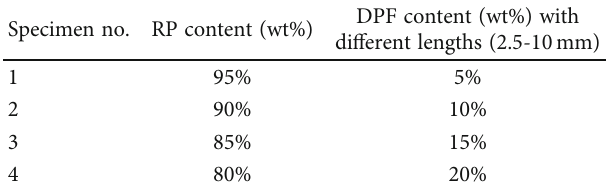
Figure 2: Specimens ’ dimensions for (a) creep, (b) impact, and (c) tensile tests. Table 2: Raw materials used to prepare the specimens. Specimen no. RP content